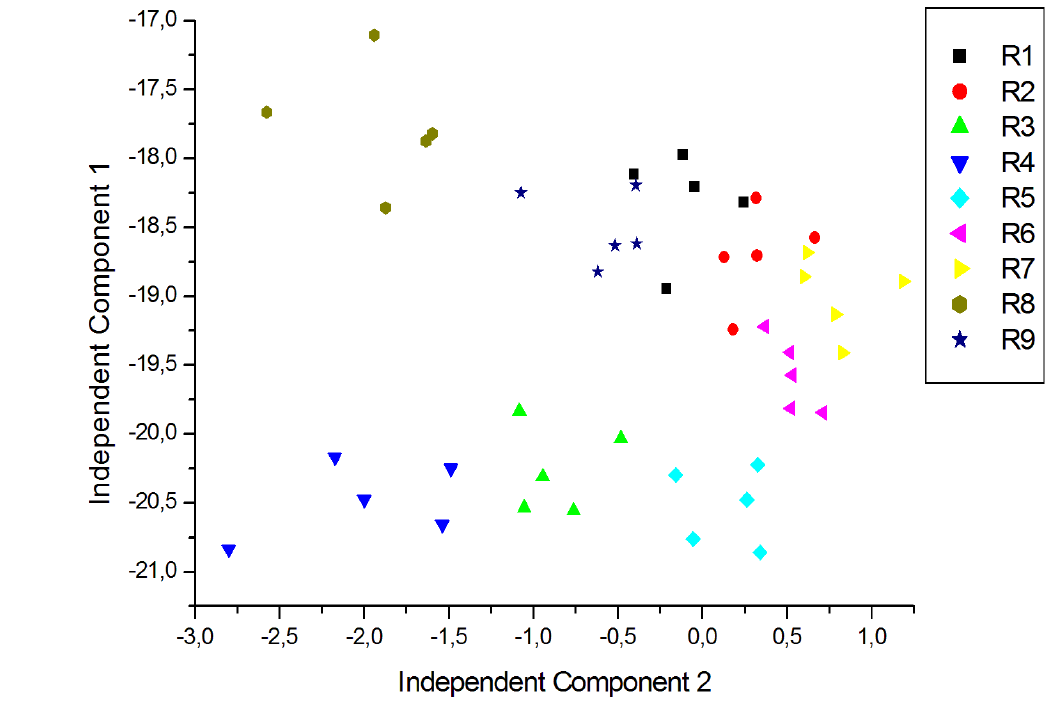
Figure 8. ICA plot of the young red wine measurements.